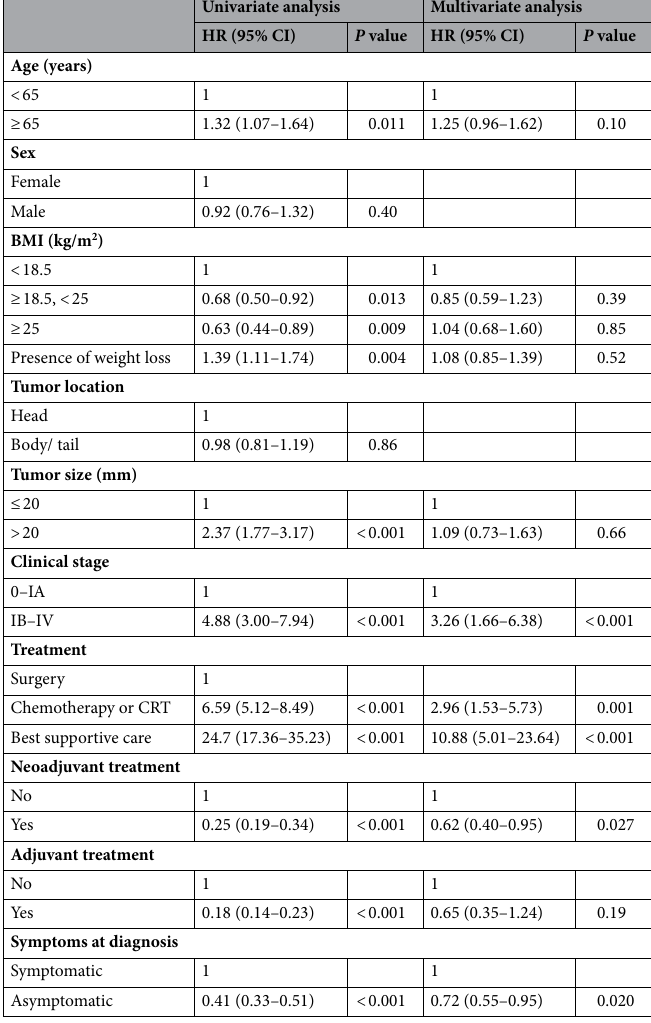
Table 3. Univariate and multivariate analyses of the factors which are associated with OS. BMI body mass index, CRT chemoradiotherapy, DM diabetes mellitus, HR Hazard ratio, OS overall